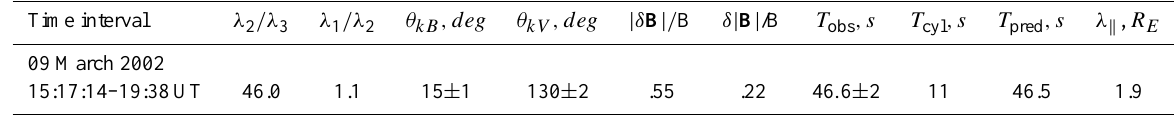
Table 1. Properties of ULF waves associated with the gyrating ion distributions. Time interval